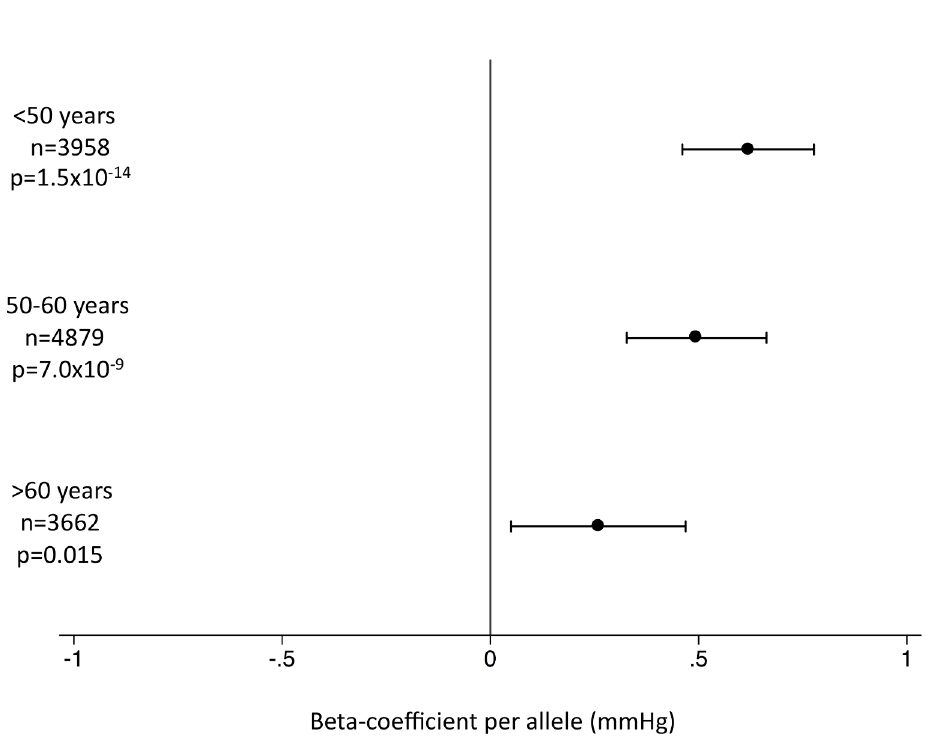
Fig 3. Association of the systolic blood pressure genetic score with systolic blood pressure by age stratum in the EPIC-InterAct subcohort. This figure shows the association between the genetic score for SBP and SBP in the EPIC-InterAct study by age stratum [26]. Analyses were adjusted for sex, center of recruitment, and subcohort status.